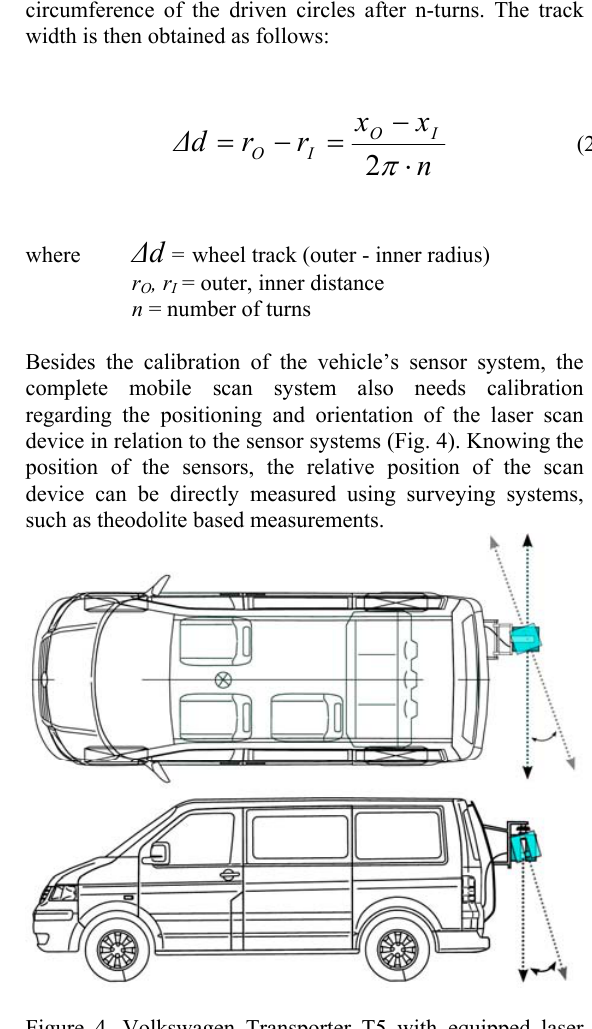
Figure 4. Volkswagen Transporter T5 with equipped laser scan device (Z+F Imager 5006) at the car’s rear end. Top: Variation of the yaw angle. Bottom: Variation of the scanner’s pitch